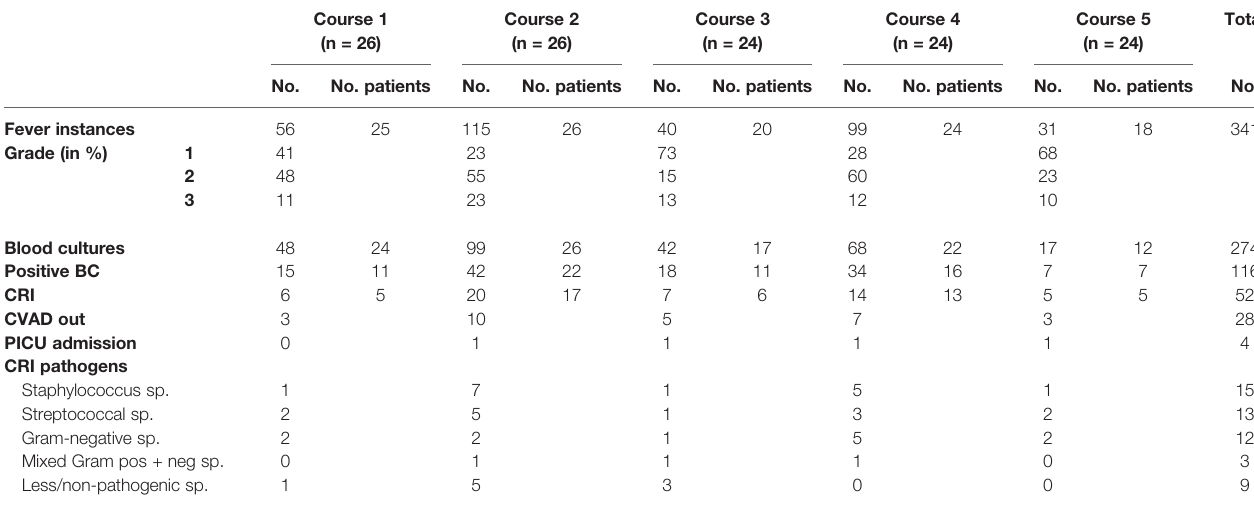
TABLE 3 | Fever instances, blood cultures, and catheter-related infections.